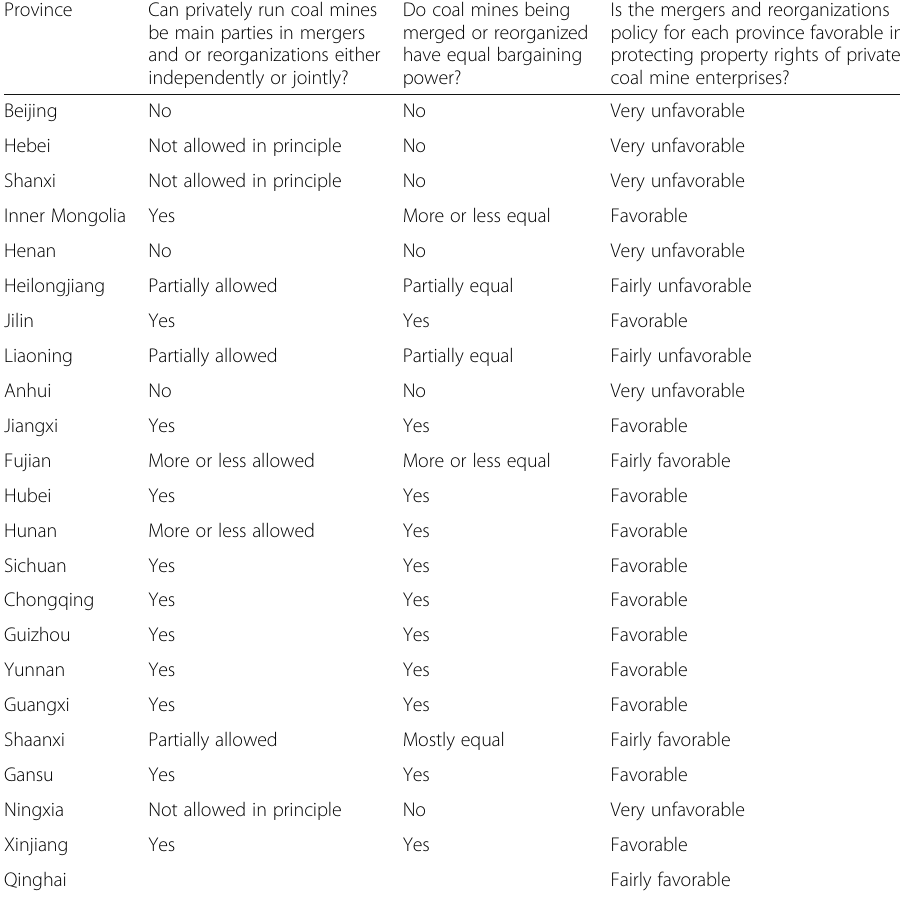
Table 3 Assessing the degree of property rights protection based on each province ’ s mergers and reorganizations policy